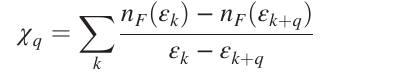
FIG. 6. Nesting signatures in the reciprocal space of magnetite. Selected reciprocal space patterns of magnetite at T hand panels of (a) and (b)] in the (a) HK0 plane and (b) HK4 plane are compared to the Fermi surface nesting construction [right-hand panels of (a) and (b)]. Dark features in the nesting construction correspond to more efficient nesting. Common features are underlined or encircled by dashed lines. The contours of the Brillouin zone are superposed on the right-hand subpanels, X points are indicated. Note that the X point is avoided, in both the experiment and the